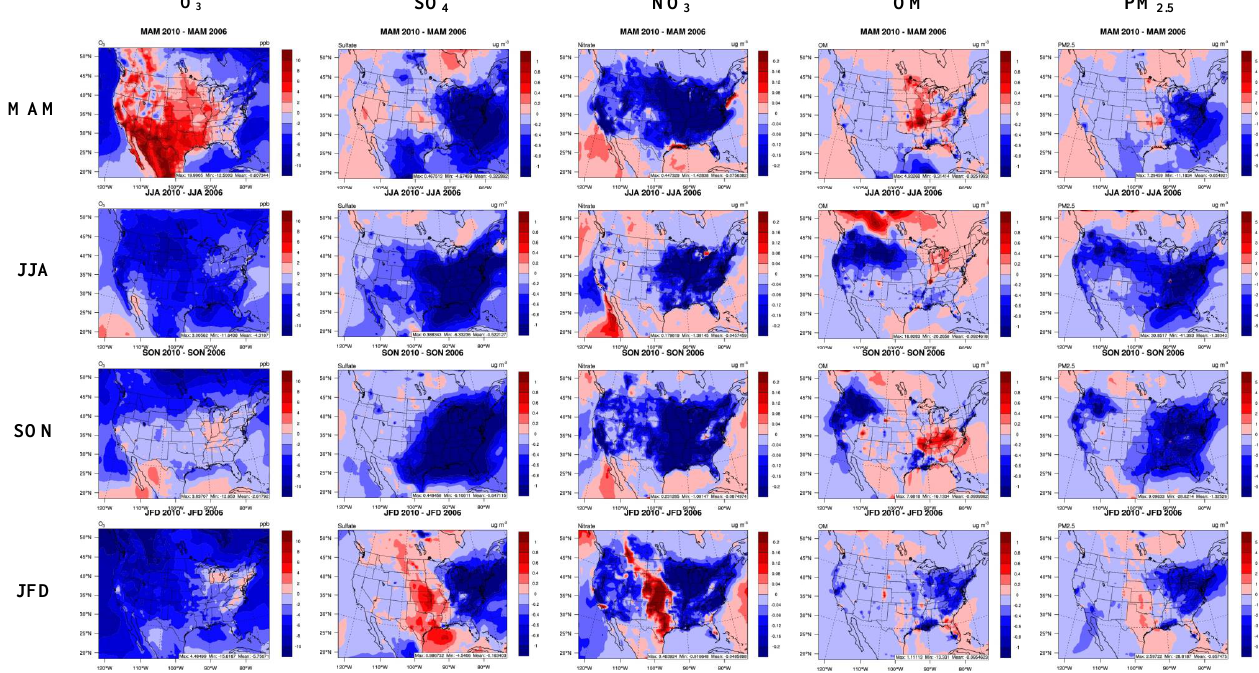
Figure 11. Changes in hourly average surface concentrations of O 3 and PM species from 2010 to 2006